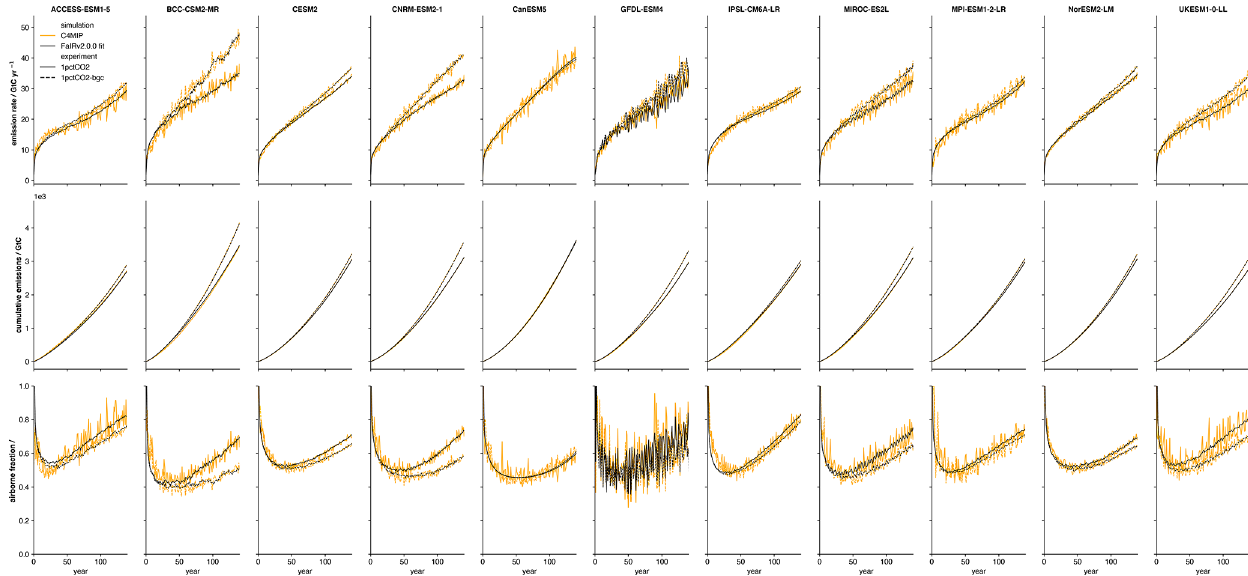
Figure 4. FaIRv2.0.0 emulation of CMIP6 model carbon cycle response to the C4MIP 1pctCO2 experiments. The black line shows FaIRv2.0.0-alpha emulation, and the orange line shows C4MIP model data. The top row shows diagnosed emission rates, the middle row shows cumulative emissions, and the bottom row shows airborne fraction. The solid line indicates the fully coupled C4MIP runs, while the dashed lines show biogeochemically coupled runs (emulated in FaIRv2.0.0-alpha by setting r T = 0). Table 4. Tuned CMIP6 aerosol forcing